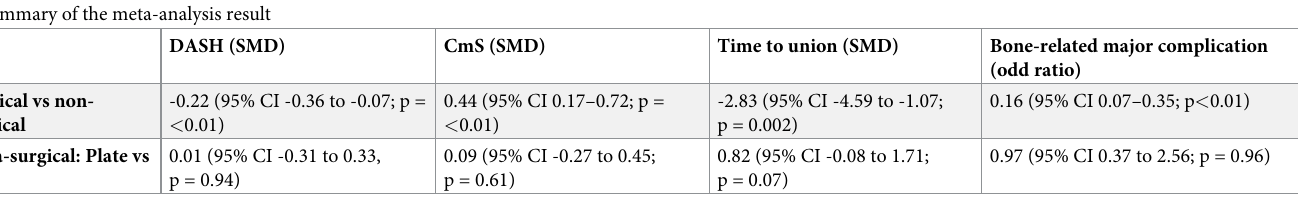
b. Comparison of the standard-mean difference (SMD) and mean difference (MD) of DASH Score and Constant-Murley Score at different time points between surgical treatment and conservative